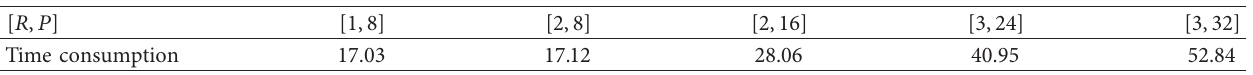
Table 4: Time consumption in feature extraction of circular LBP operator under different radius and sampling points (units: s).